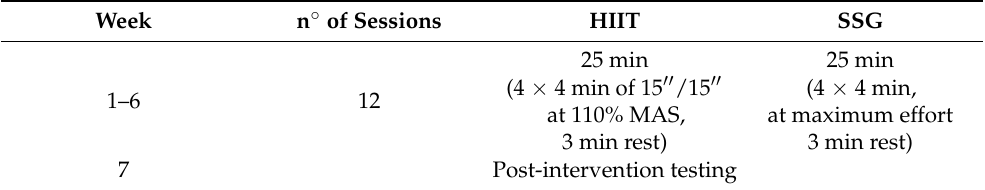
Post-intervention